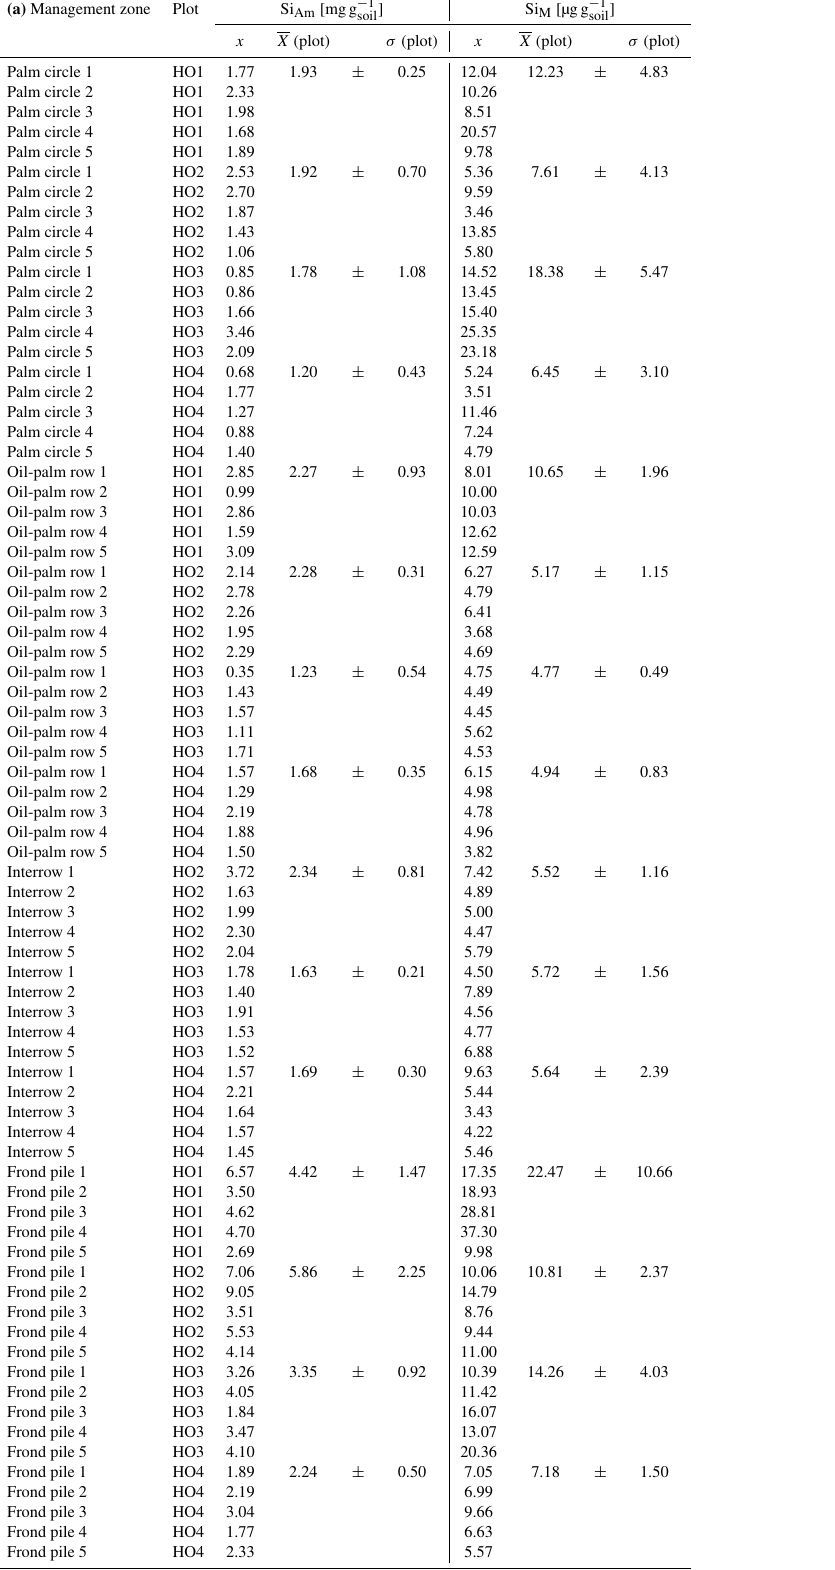
Table B2. (a) Topsoil Si concentrations in different management zones of well-drained oil-palm plantations. (b) Topsoil Si concentrations in different management zones of riparian oil-palm